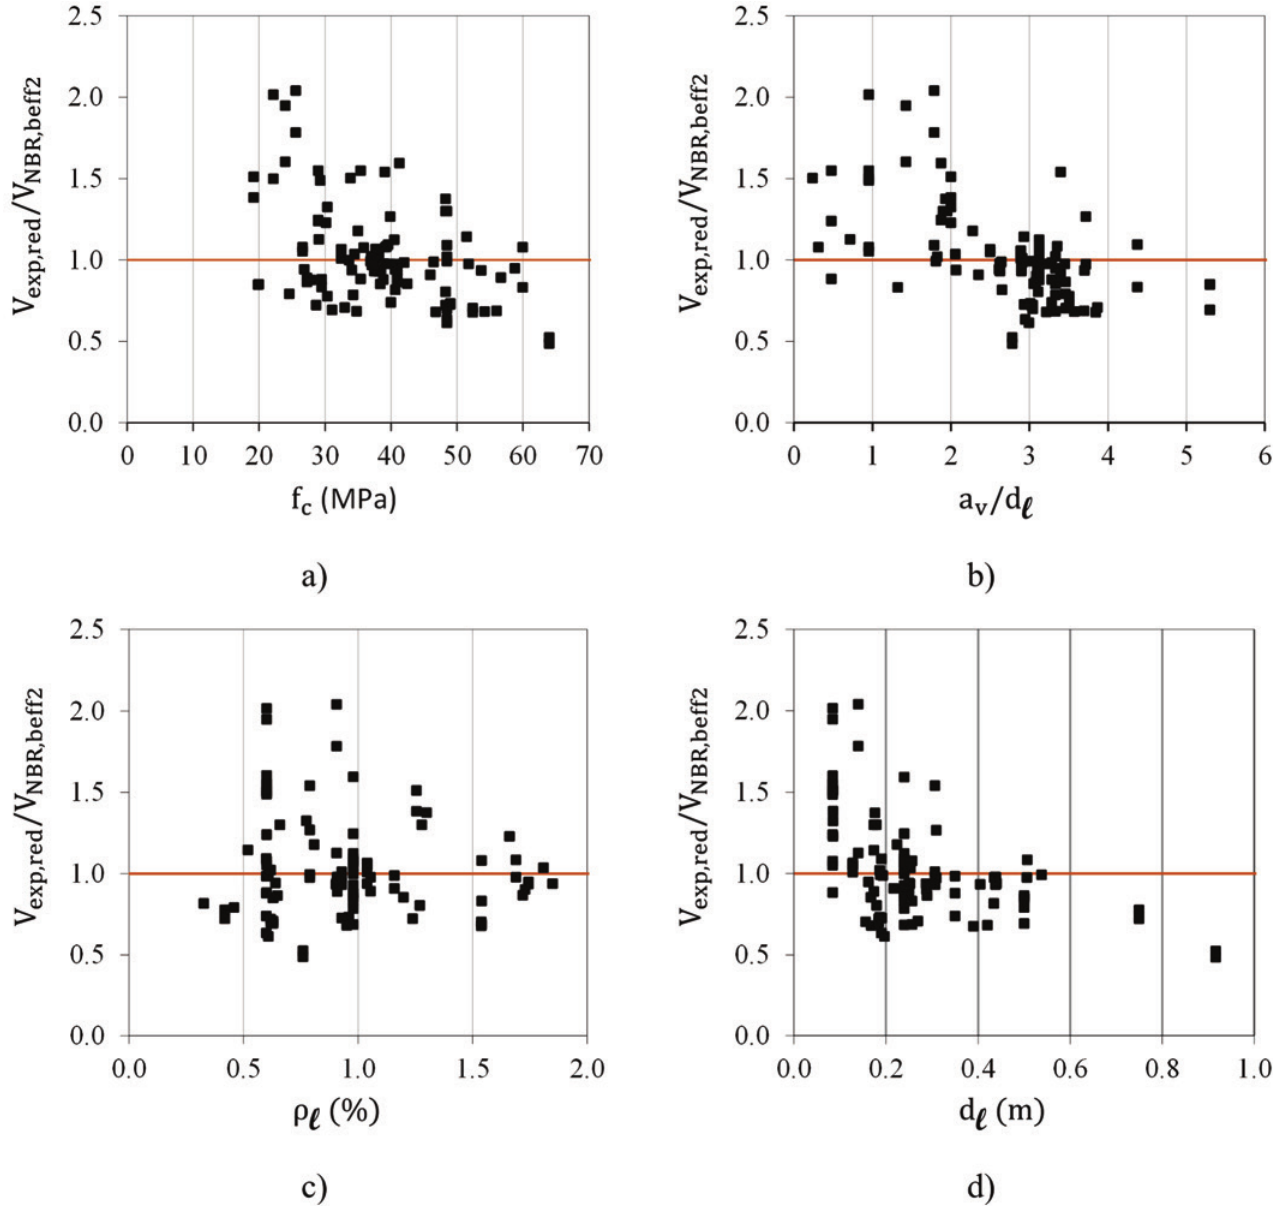
V /V ratio provided by ABNT NBR 6118:2014 according to: a) compressive strength of concrete f exp cal